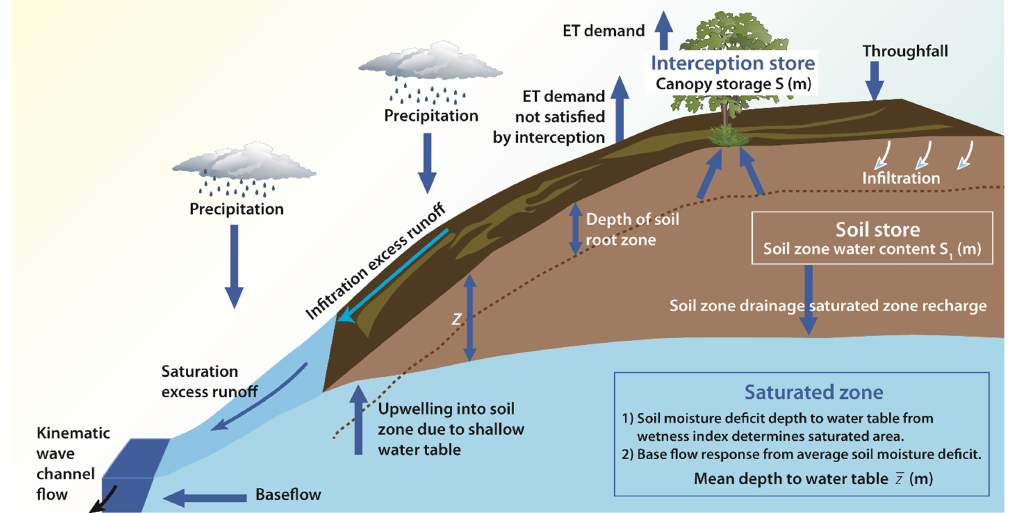
Fig. 3. Schematic representation of the water balance component of TopNet (adapted with permission from Bandaragoda et al.,